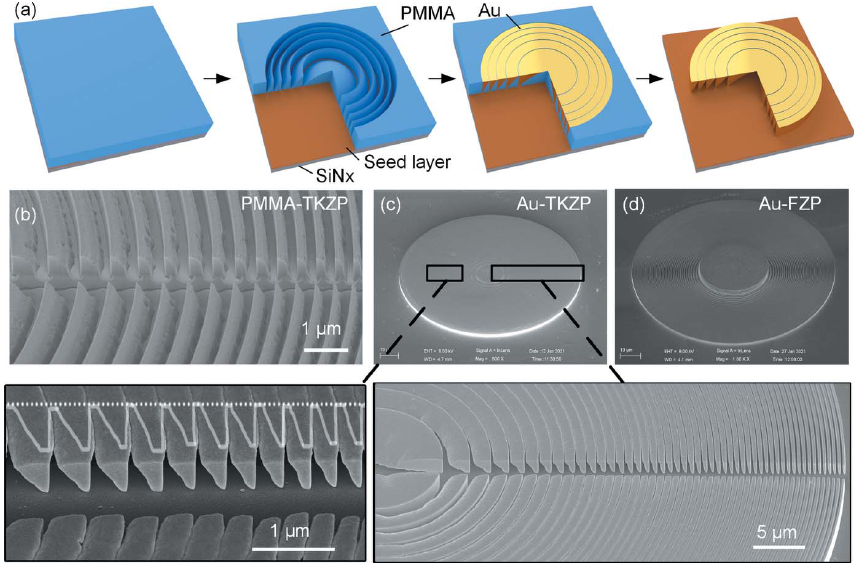
Figure 4 Overview of the fabrication procedures. ( a ) Schematic illustration of GS-EBL for the Au-TKZP lens with diameter of 100 m m and outermost zone width of 250 nm. ( b ) SEM micrographs at a tilt of 45 (cid:7) for the replicated TKZP profiles in PMMA as a template for Au electroplating. ( c ) The fabricated TKZP lens in Au. ( d ) The fabricated FZP lens with a beamstop after gold electroplating. A 2 m m-wide trench crossing the center of the plate was deliberately arranged in testing samples to inspect the trapezoid kinofom profiles. White lines are the digitized curves (Au-TKZP+) of the actual zone profiles of